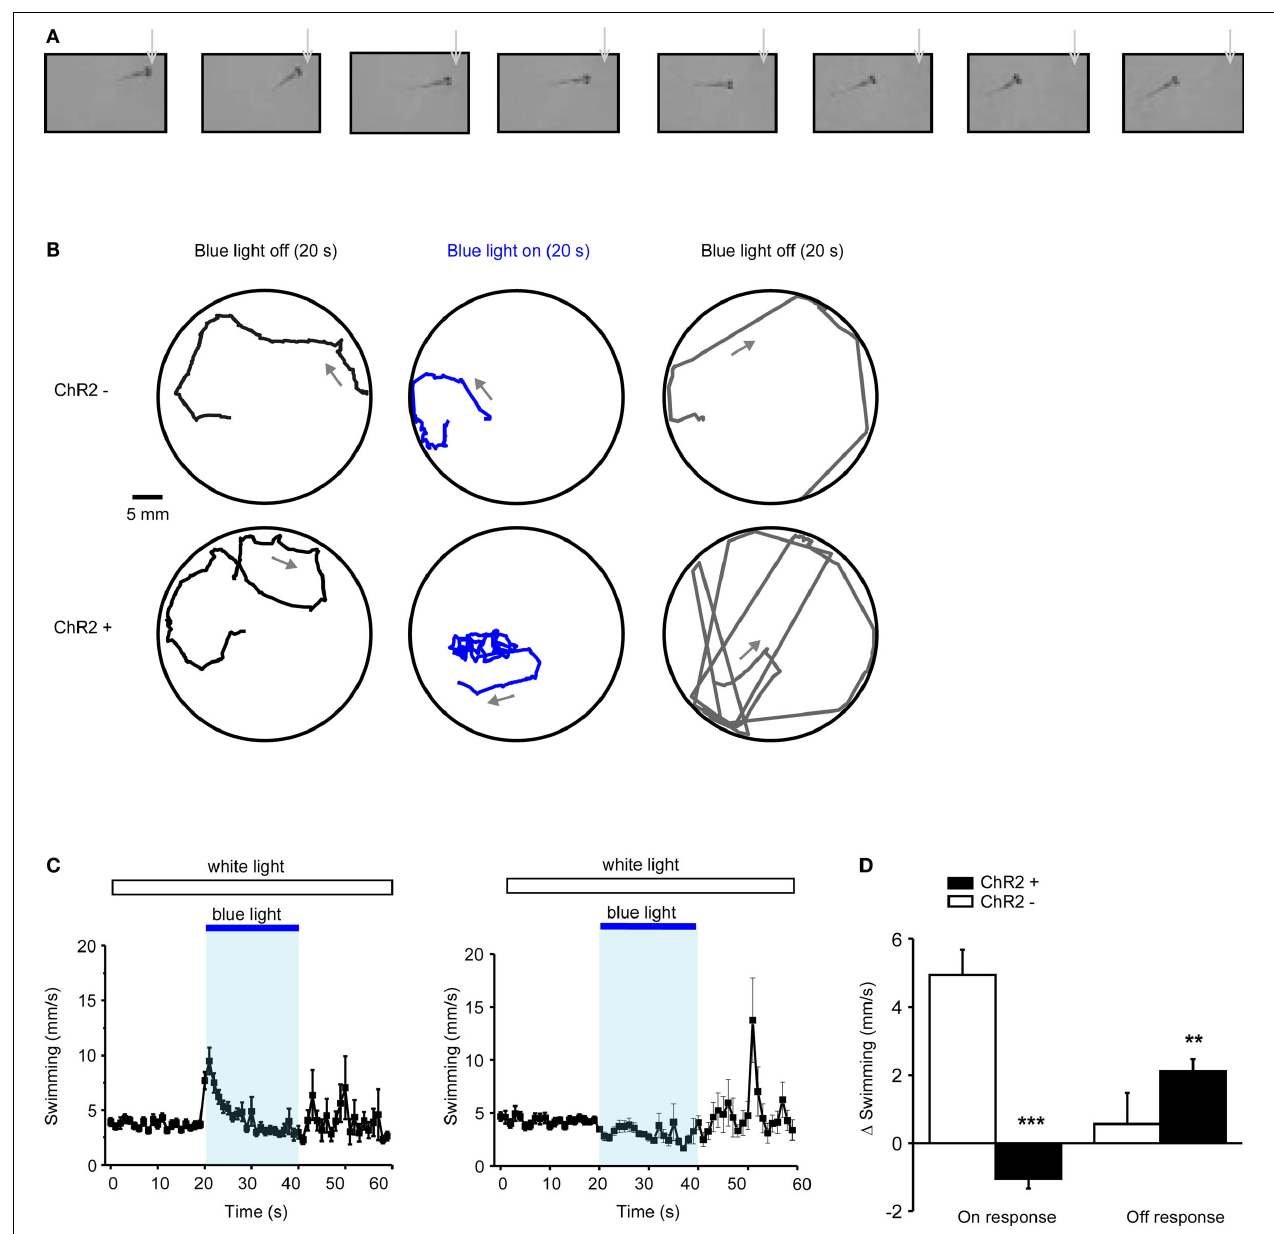
FIGURE 7 | Optical modulation of swimming behavior in larvae expressing channelrhodopsin-2 under Tet control. (A) Video frames taken immediately after onset of blue light (LED; inter-frame interval: 300 ms). Note that the larva (HuC:itTA/ Ptet:ChR2YFP Line 03) swims backwards (see also Movie S1 in Supplementary Material). (B) Examples of swimming trajectories of individual larvae (ChR + : HuC: itTA/Ptet:ChR2YFP Line 03; ChR-: wild-type sibling) during 20-s periods before,